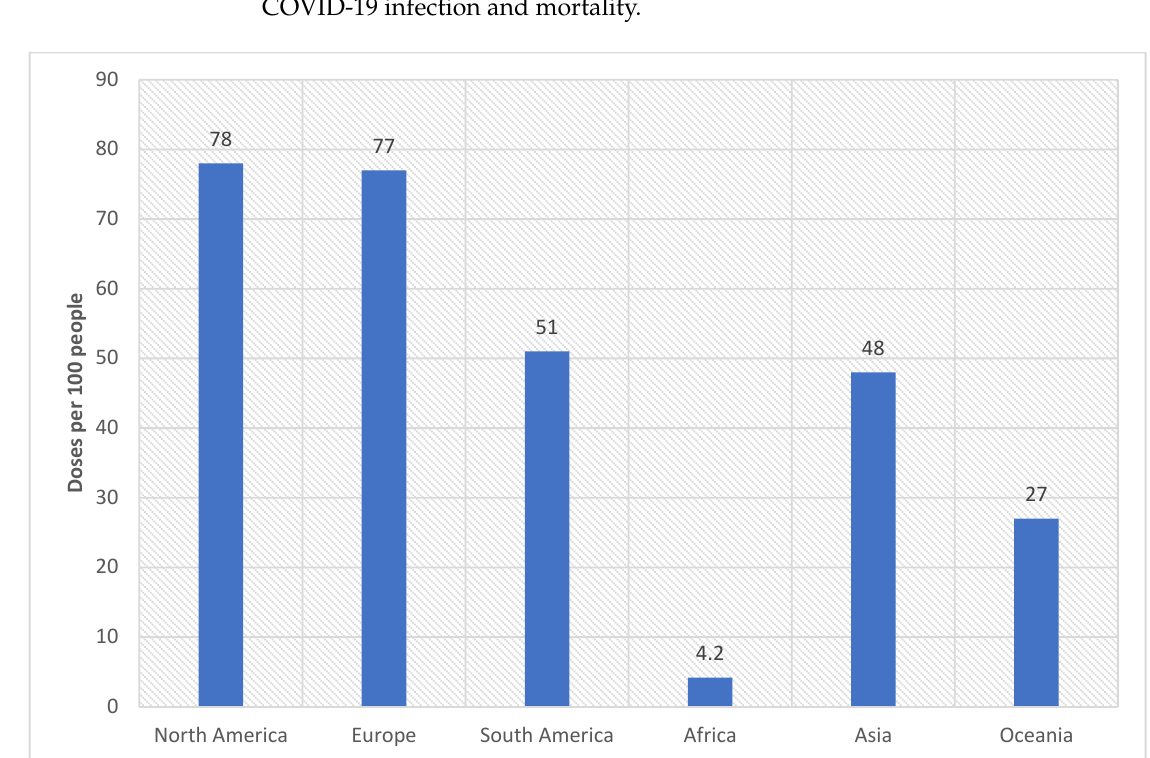
Figure 4. The global disparity in the COVID-19 vaccination doses per 100 people (data source: The New York Times [98]).